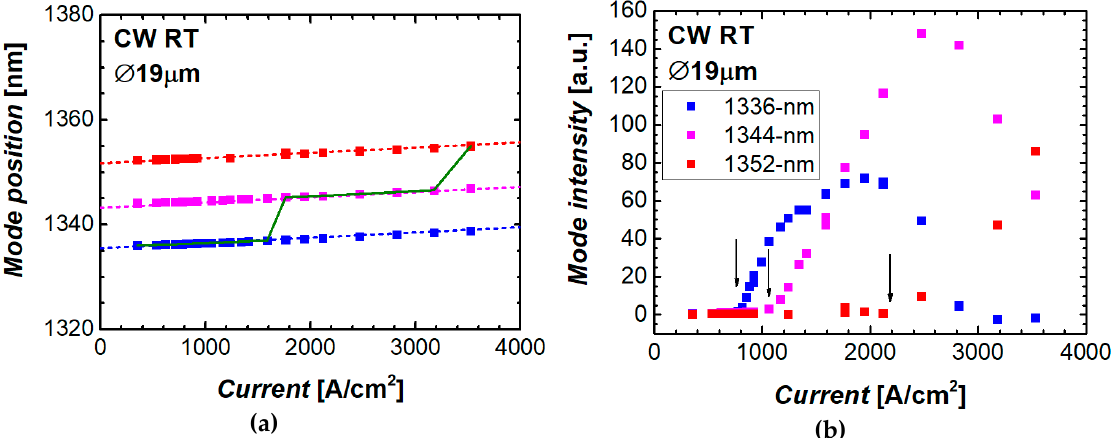
Figure 6. Spectral position ( a ) and integrated intensity ( b ) of the three most intense modes of the 19 µm microdisk laser against current density. Dotted lines in ( a ) correspond to the slope of 1 nm/(kA/cm 2 ), solid line—spectral position of the most intense mode; arrows in ( b ) indicate the mode threshold.